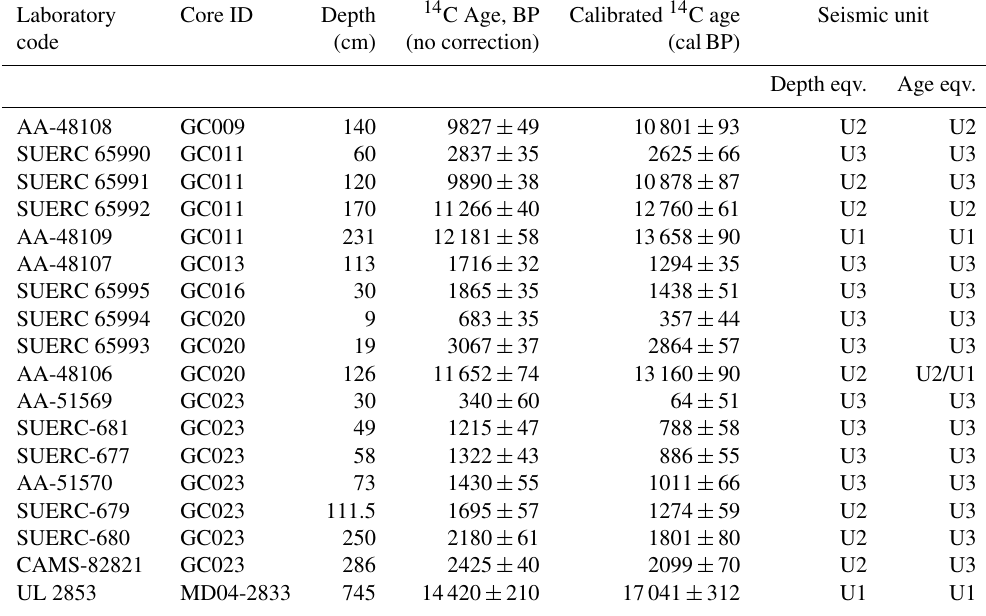
Table 2. Radiocarbon ages from Loch Sunart cores. Ages were calibrated using OxCal 4.2.4 (Bronk Ramsey, 2009; Bronk Ramsey and Lee, 2013) with the Marine13 curve (Reimer et al., 2013) and regional correction of (cid:49) R value of − 26 ± 14yr (Cage et al., 2006) . All ages are calibrated at 95.4% probability and the mean age has been determined from the minimum and maximum calibrated ages. Additionally, we list the seismic unit assigned to each equivalent (eqv.) depth and compare this to the age-equivalent seismic unit based on Baltzer et al.